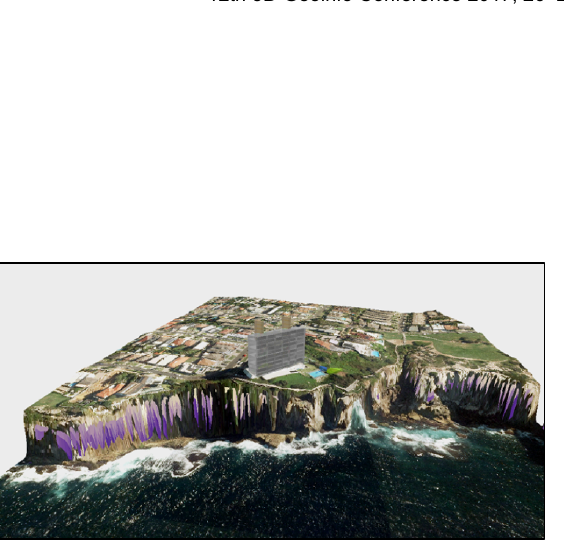
Figure 10: Captured strata plan on surface model with draped imagery